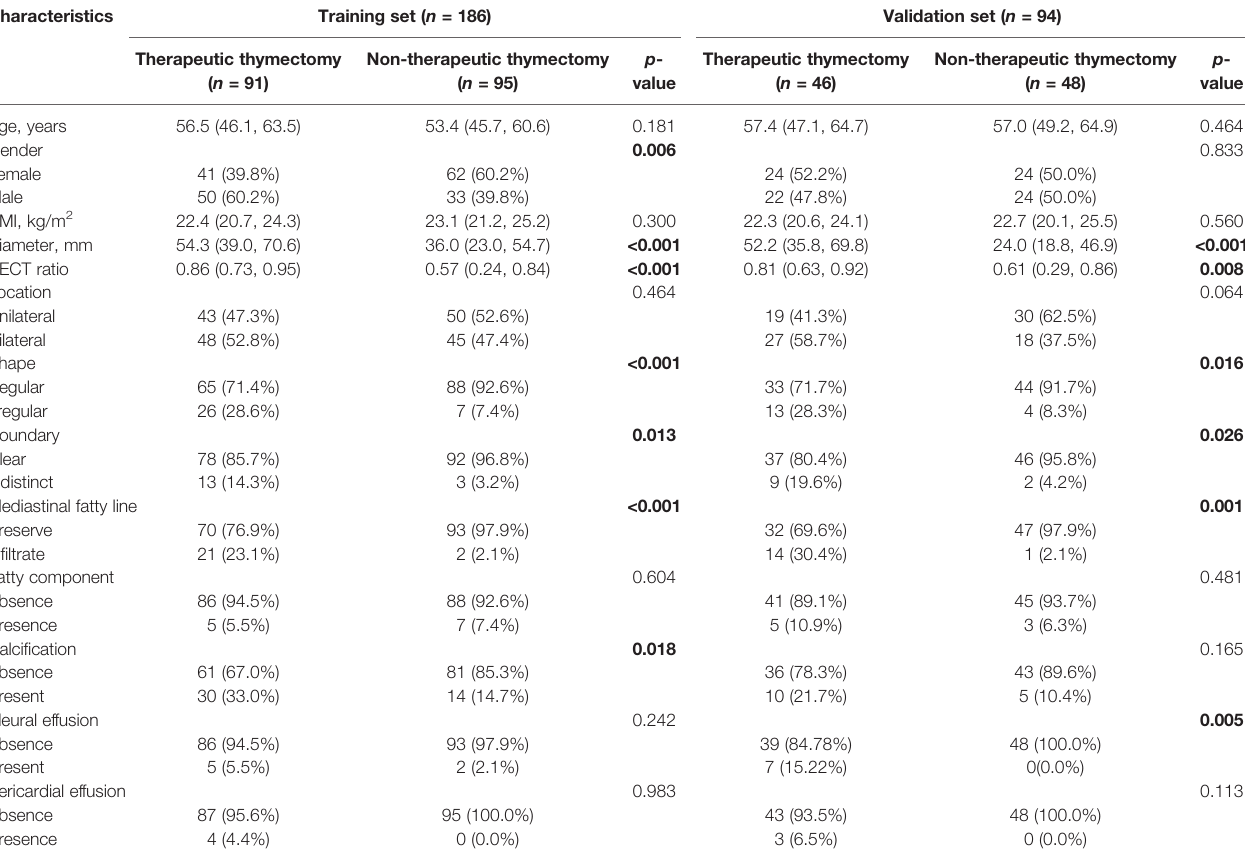
TABLE 2 | The clinical and radiographic features in the training and validation sets of UECT. Characteristics